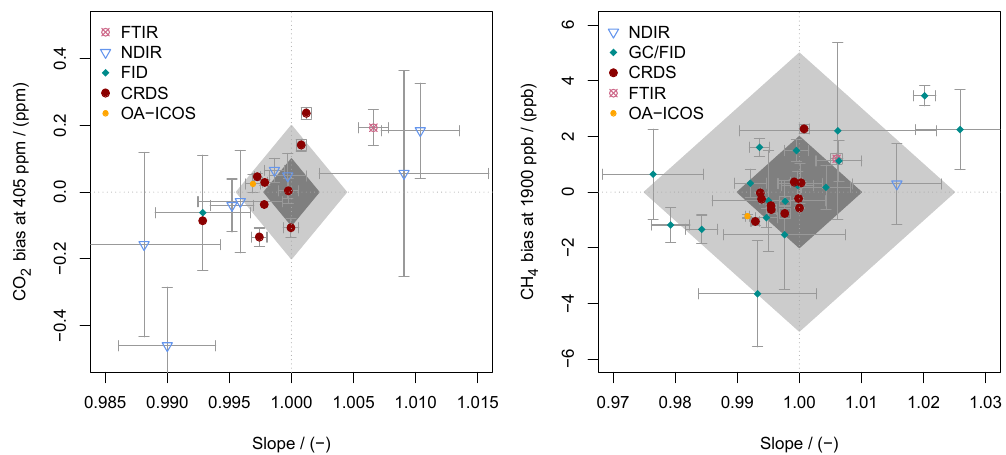
Figure 16. Left: CO 2 bias at 405ppm vs. the slope of the performance audit for individual travelling standard comparisons involving different measurement techniques of the audited station analysers. Right: same for CH 4 , with bias at 1900ppb. The dark grey and light grey areas correspond to the WMO/GAW compatibility and extended compatibility goals for the range from 1700 to 2100ppb CH 4 and from 360 to 450ppm CO 2 .